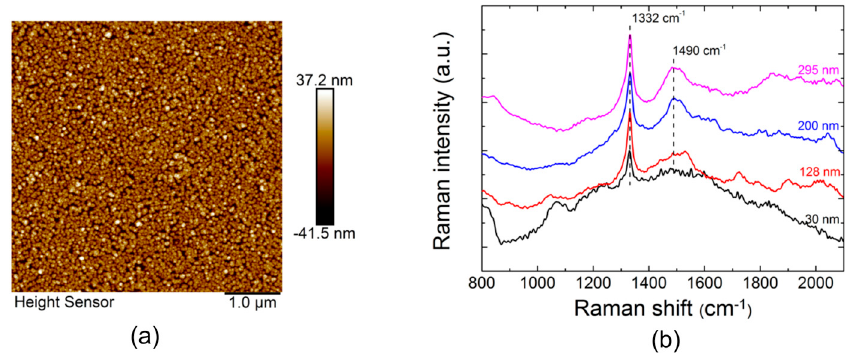
Figure 1. ( a ) AFM picture of 30 nm thick NCD layer deposited on a LW-SAW device; ( b ) Raman spectra of NCD layers with different